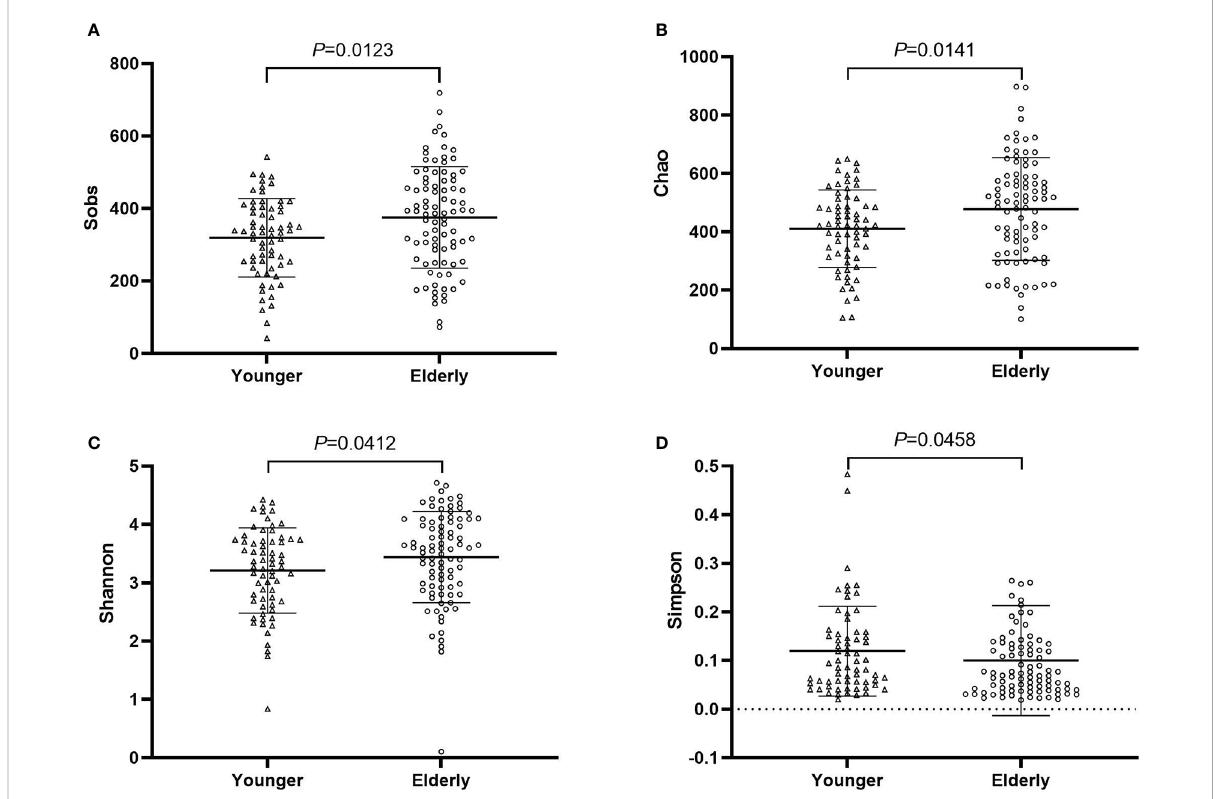
FIGURE 7 The community richness and diversity of gut microbiota for younger and elderly. (A) : Sobs index; (B) : Chao index; (C) : Shannon index; (D) : Simpson